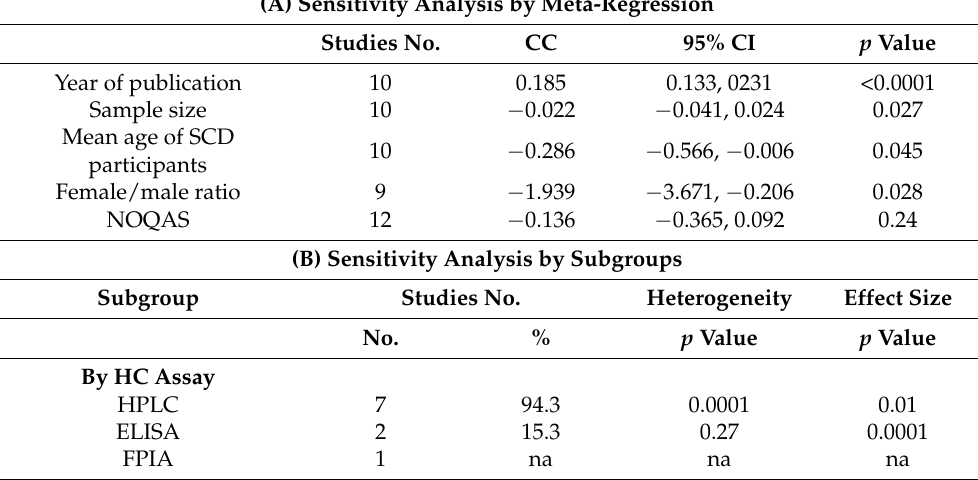
Table 5. Sensitivity analysis in the paediatric sickle cell disease/control comparison for plasma homocysteine. (A) Sensitivity Analysis by Meta-Regression Studies No. CC 95% CI Sample size Mean age of SCD